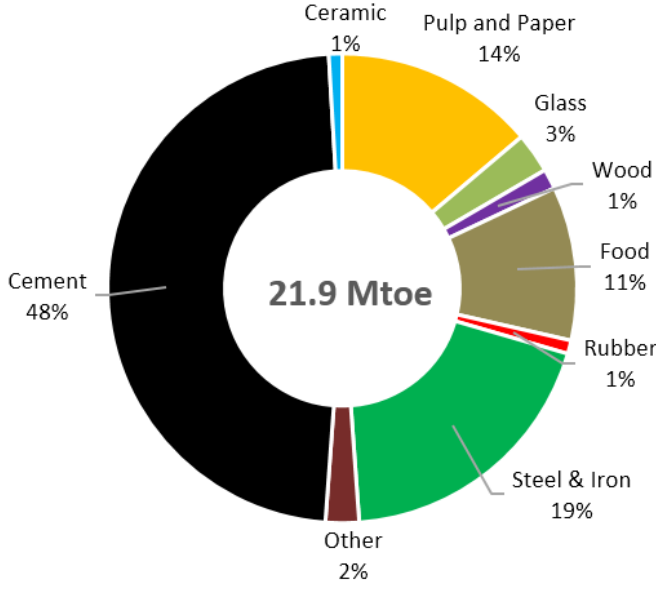
Figure 14. The structure of residential energy consumption in Malaysia in 2011.